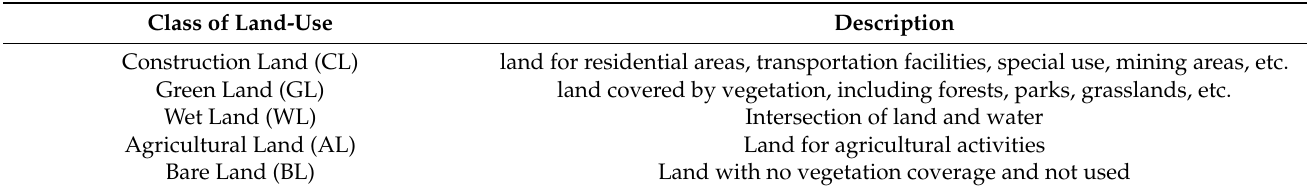
Table 1. Descriptions of land-use classification.